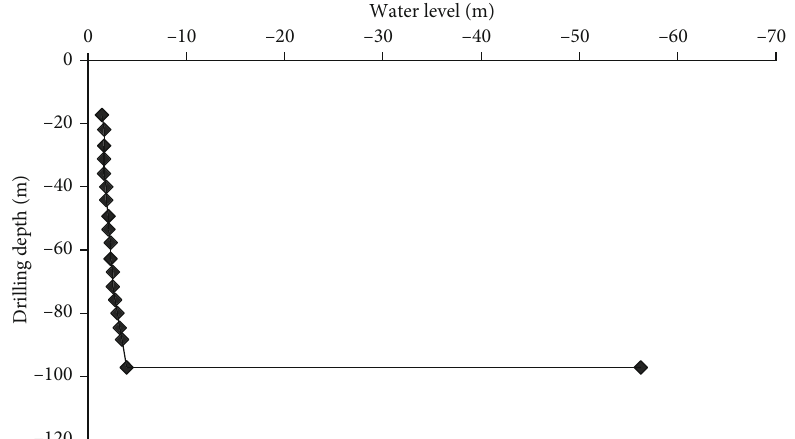
Figure 8: The change of water level of the drilling borehole in the water inrush area.